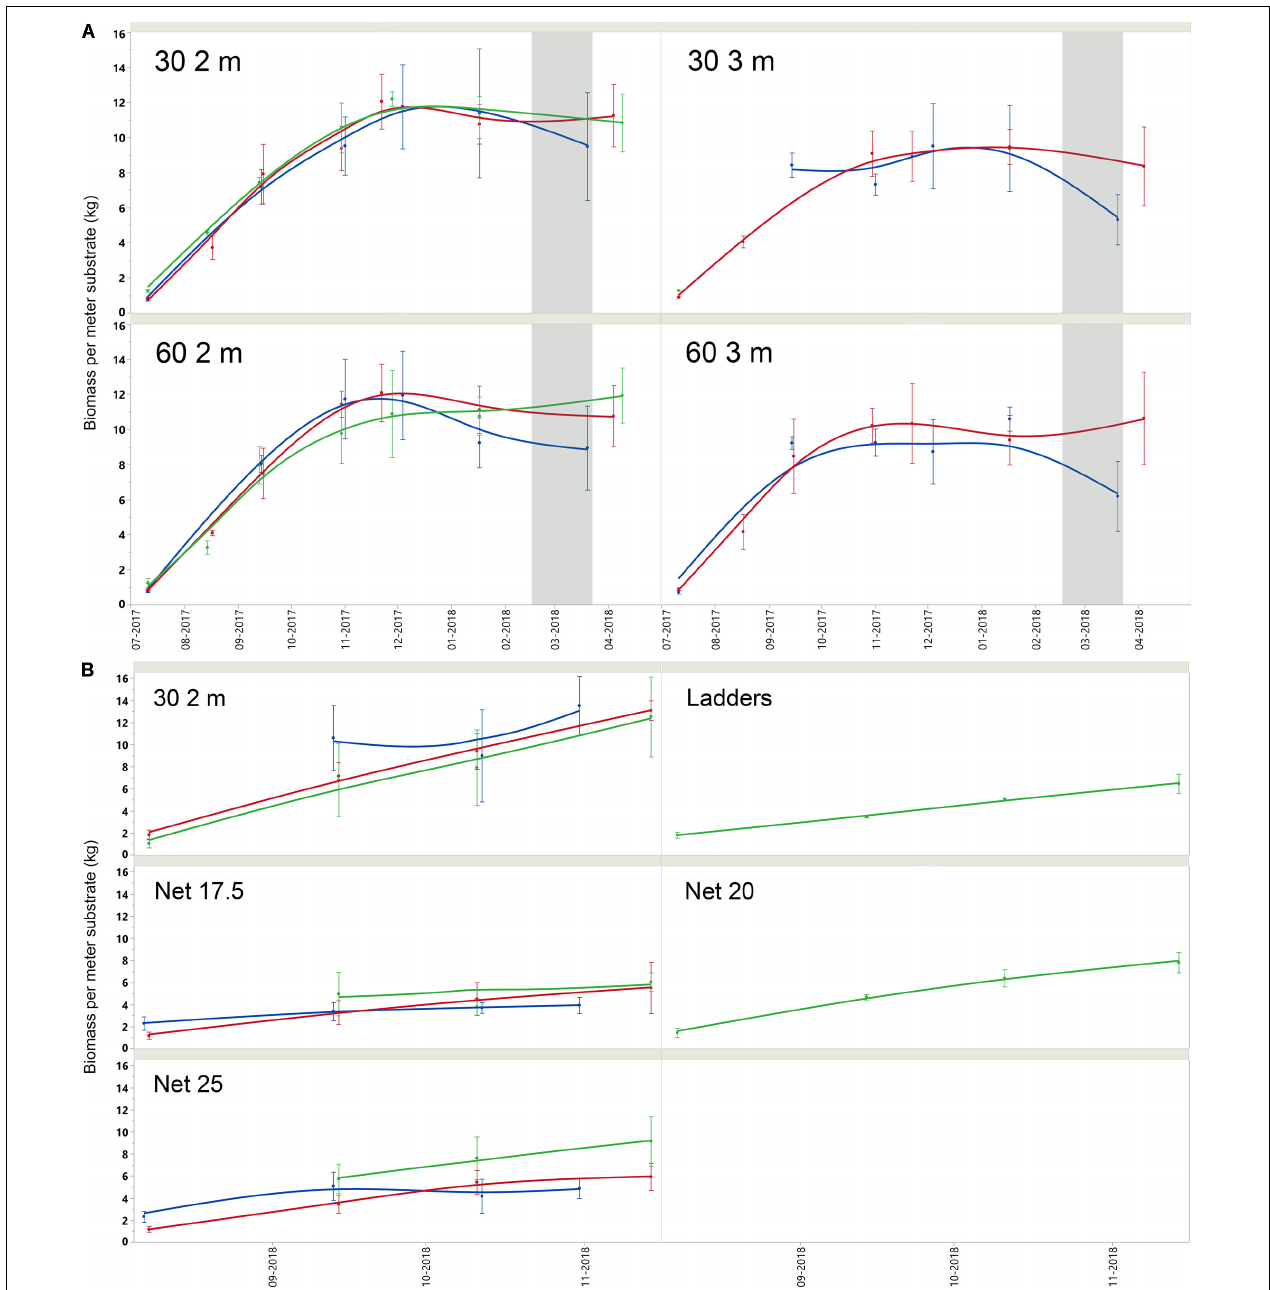
FIGURE 4 | (A) Mean and standard deviation (bars) of mussel biomass per meter length substrate for belt spat collector treatments over the growing season. Note that ice cover was present between late February and late March 2018 (gray shading). Farms are represented by color; SKIV (blue), DV (red), SALL (green). (B) Mean and standard deviation (bars) of mussel biomass per meter length substrate for alternative technologies and one belt spat collector treatment over the growing season in 2018. Farms are represented by color; SKIV (blue), DV (red), SALL (green).